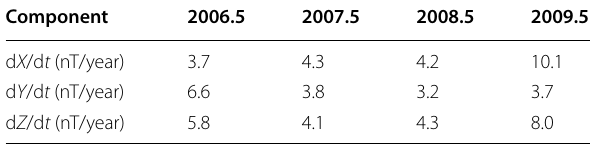
These differences were computed using 684 data points over the modelled area. The secular variation values were computed by getting the change of the field between two consecutive epochs of 1 year interval (e.g. epochs 2006.0 and 2007.0 were used to get secular variation values at 2006.5